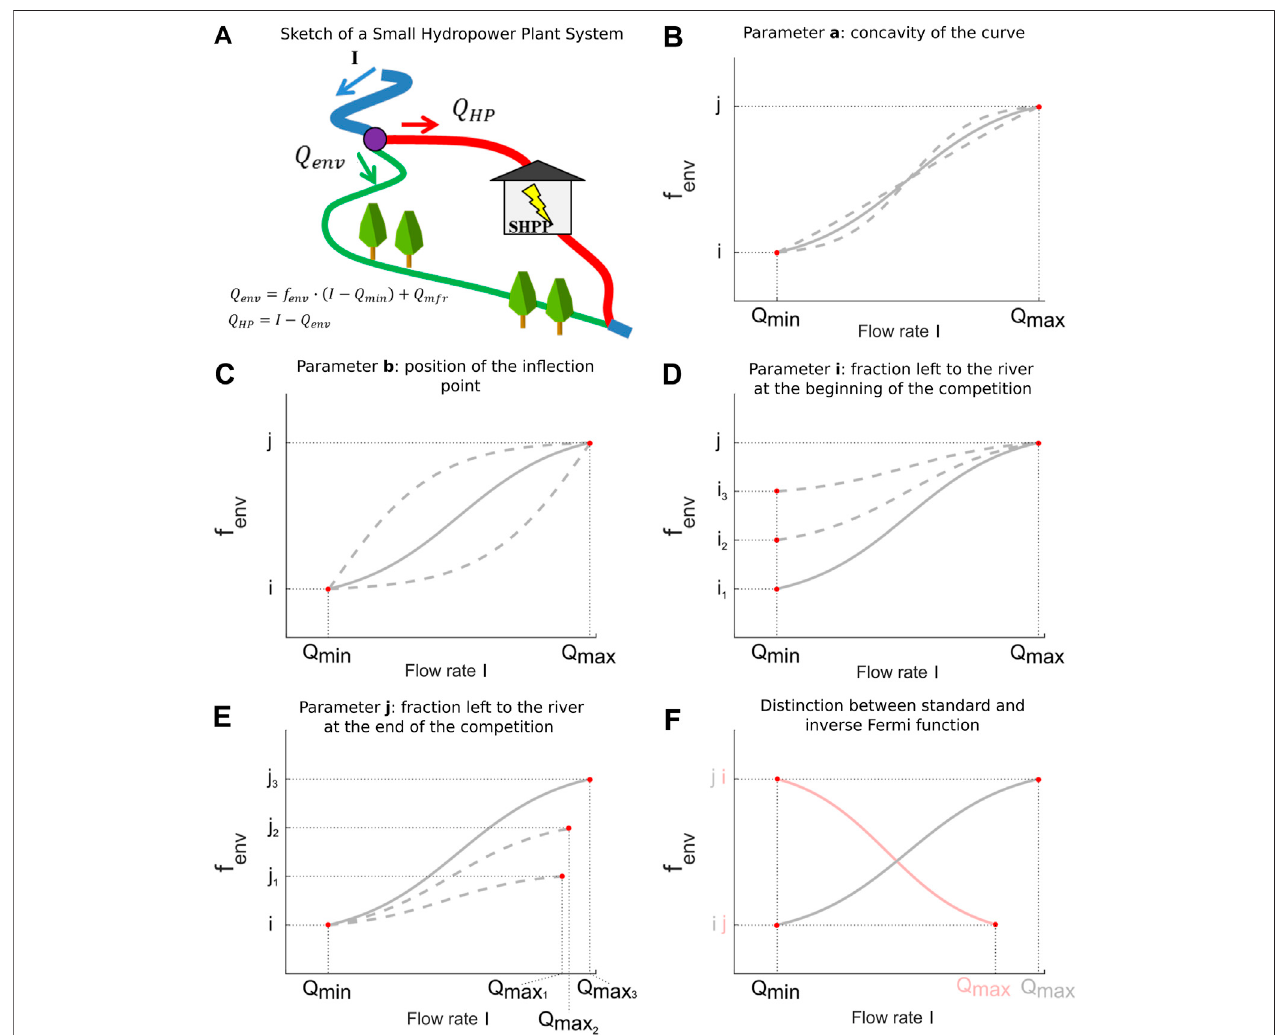
FIGURE 1 | (A) Sketch of a run-of-the-river SHP. A part of the natural incoming fl ow at the intake I (blue line)is diverted to the powerhouse Q hp (red line). The remaining fl ow rate Q env is left to the river (green line). (B)(C)(D)(E) In fl uence of the parameters a , b , i and j on the shape Fermi function. (F) Distinction between the standard Fermi function (gray curve) and the inverse Fermi function (pink